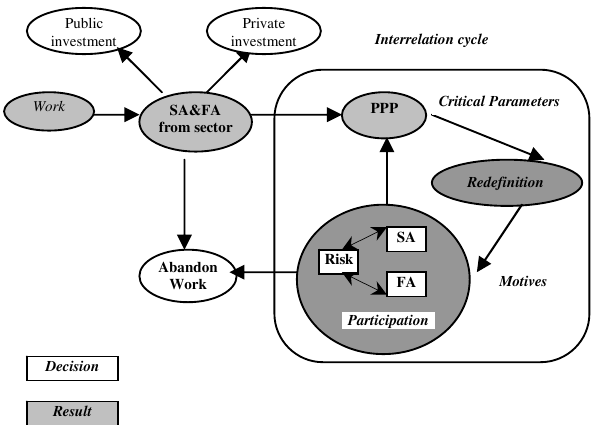
Fig 1. The interrelation process in co-funding projects on a PPP